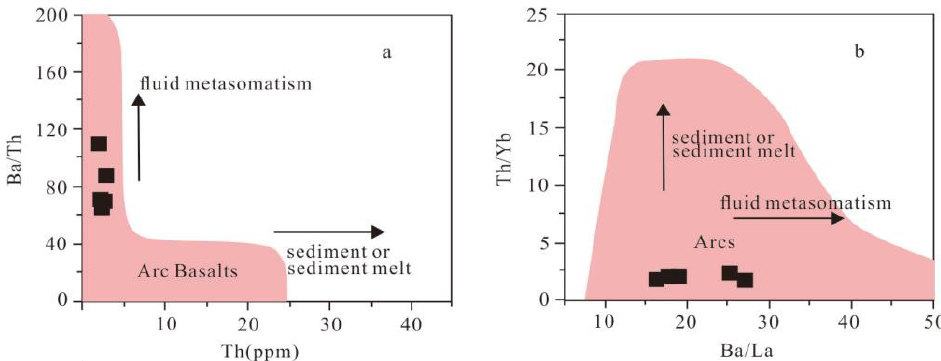
Figure 10. ( a ) Plot of Ba / Th vs. Th (ppm), the pink area represents the arc volcanic rocks worldwide (Kirchenbaur et al. [37] and references therein). ( b ) Th / Yb vs. Ba / La diagram, the pink area